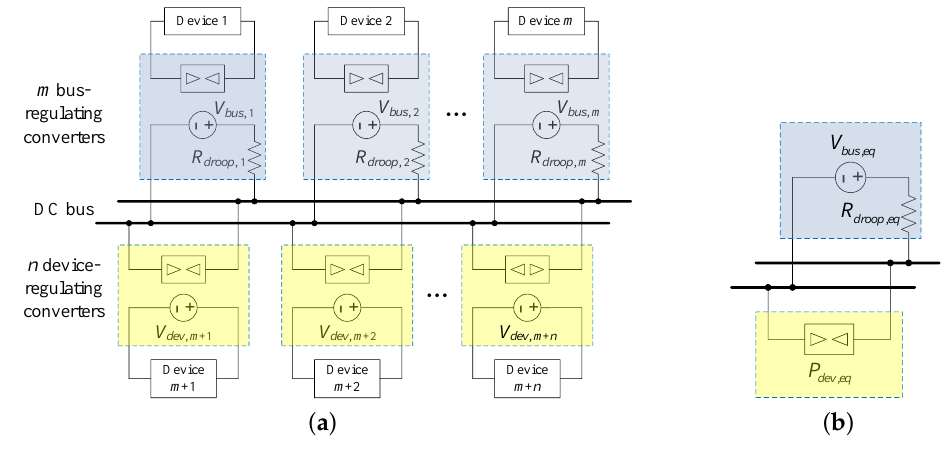
Figure 3. ( a ) Circuit diagram of the DC microgrid where m converters work in the bus-regulating mode and n converters work in the device-regulating mode. ( b ) Equivalent circuit diagram.